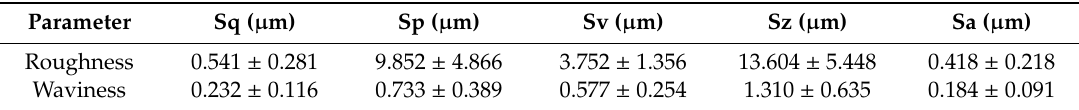
Table 2. Basic areal height parameters calculated for pre-electric discharge machined (EDM) (as-ground) surfaces according to ISO 25178-2. Data is presented as mean ± standard deviation for roughness and waviness.